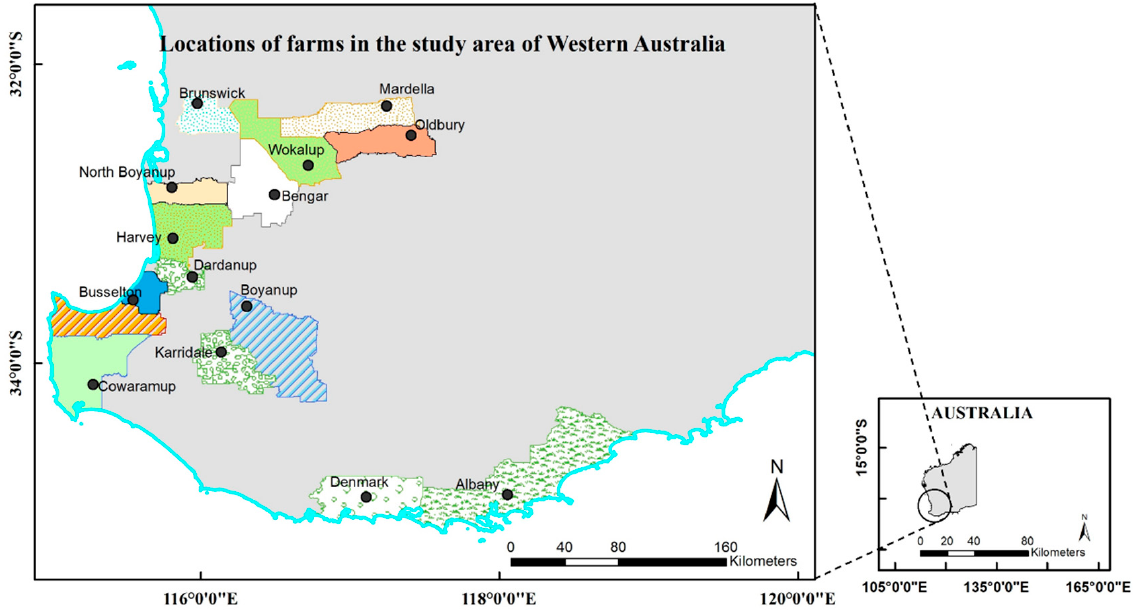
Figure 1. Locations of the farms in Western Australia for the Mycoplasma bovis seroprevalence study.